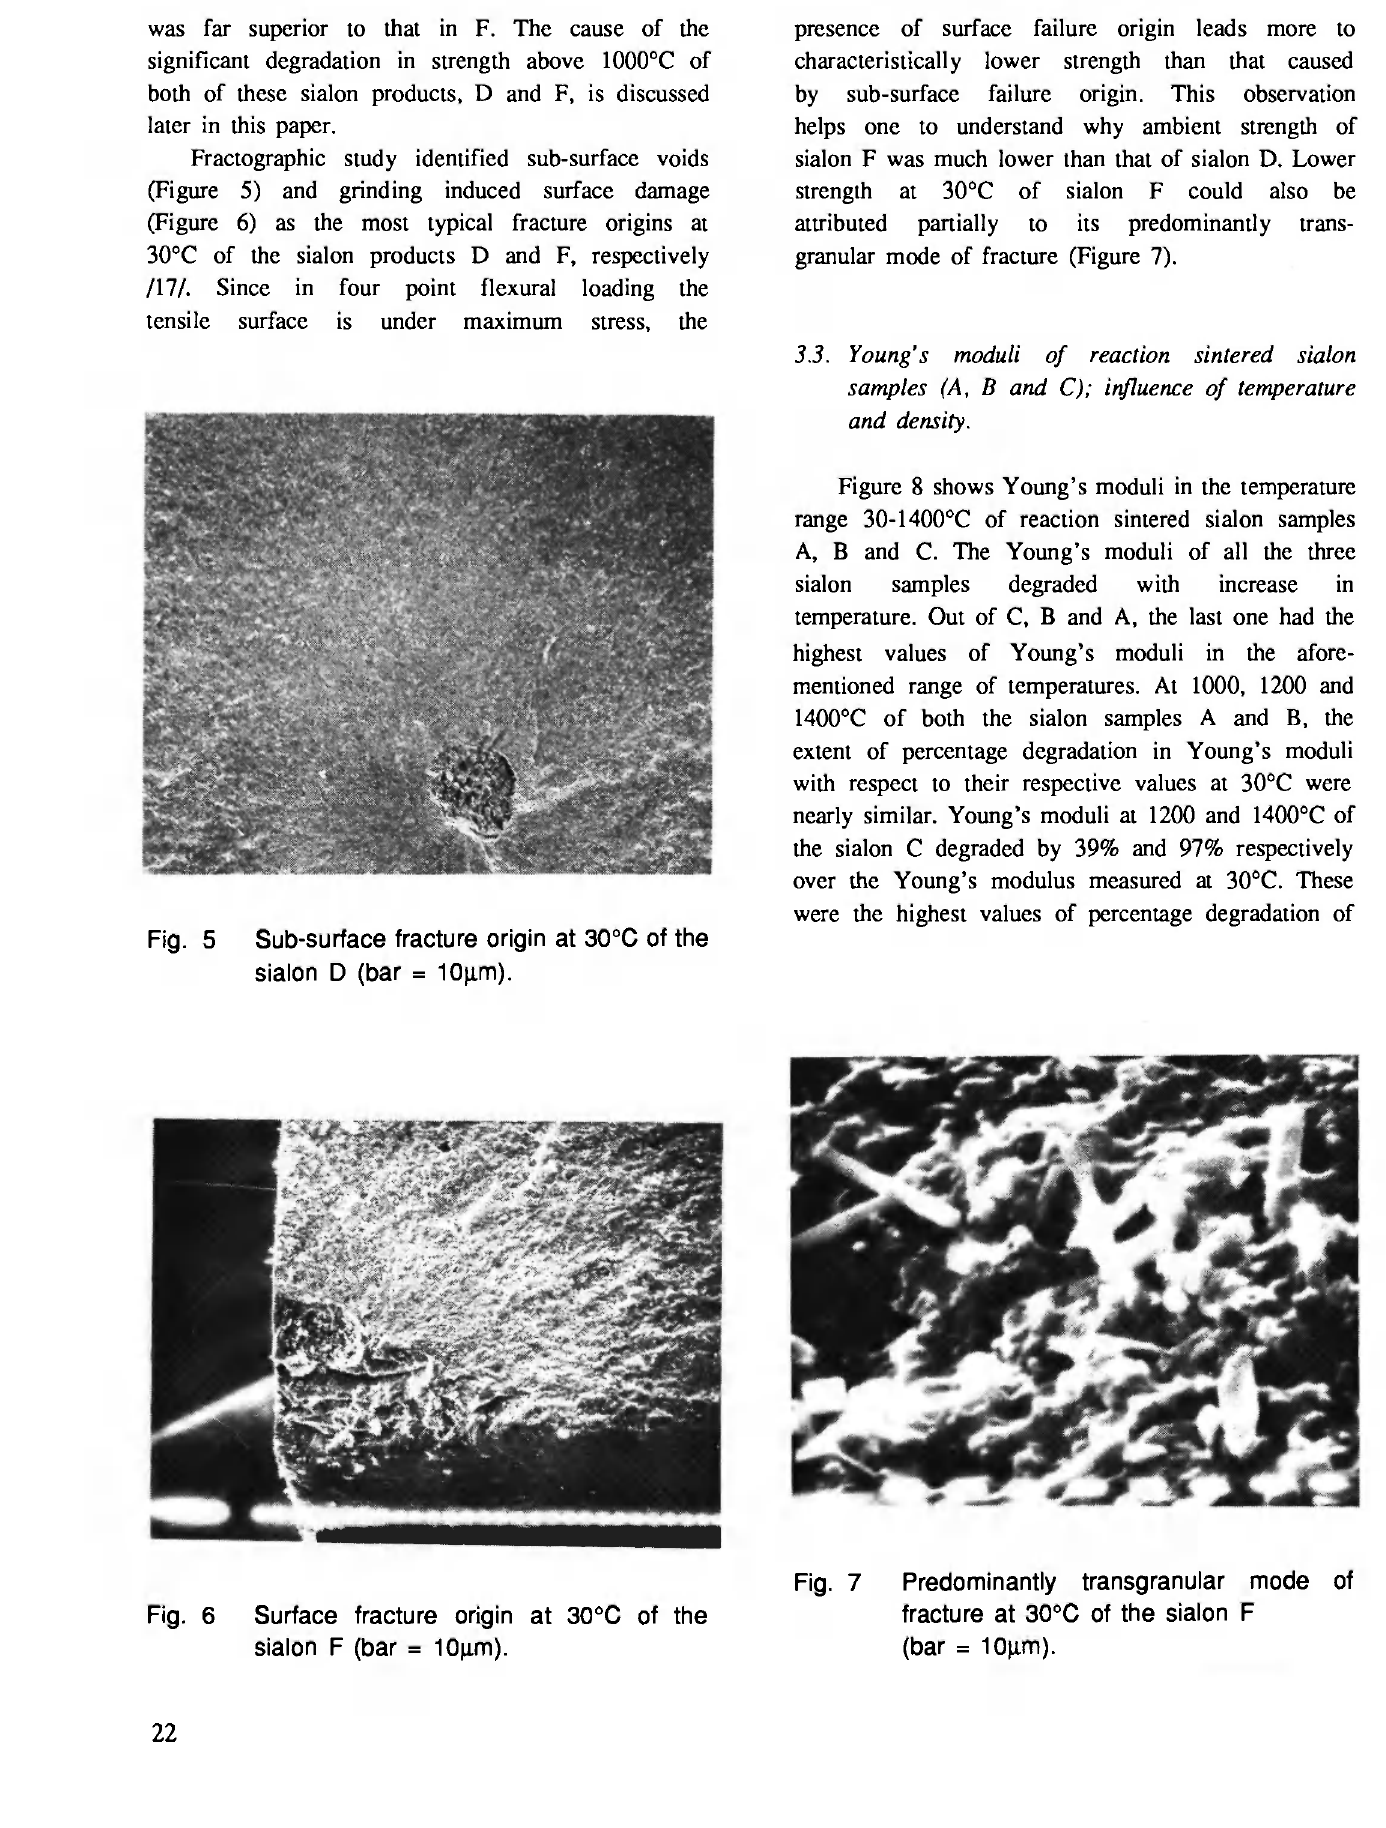
Fig. 6 Surface fracture origin at 30°C of the sialon F (bar =